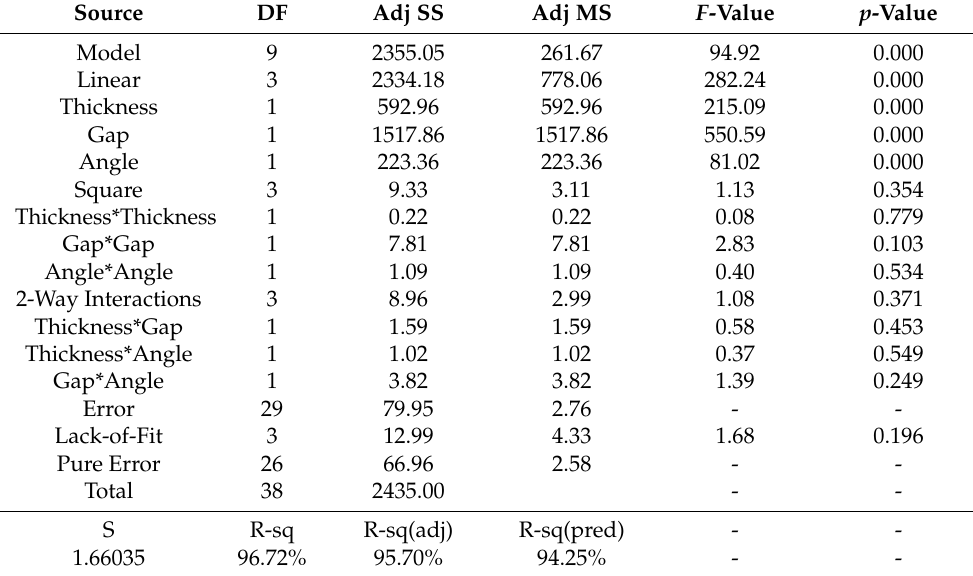
Table 6. Analysis of Variance and regression